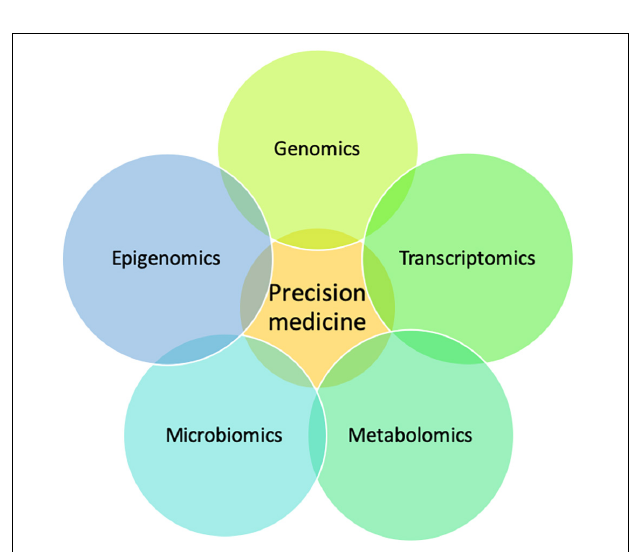
FIGURE 4 | A multi-omics approach to precision medicine. Schematic showing how the integration of multi-omics data is complementary and important for precision